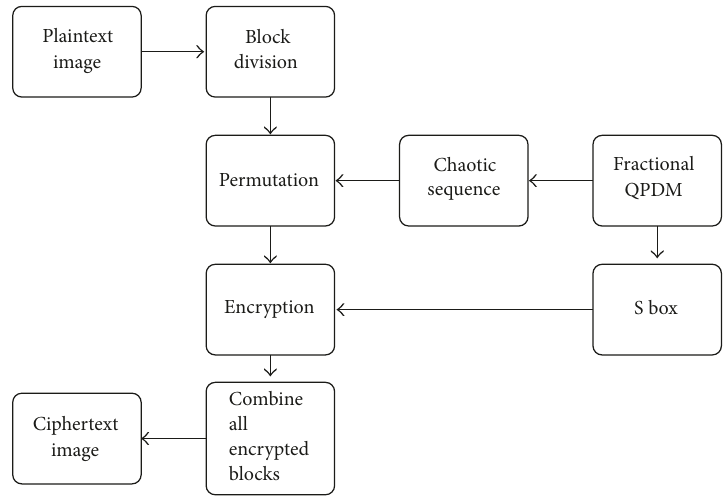
Figure 8: The proposed encryption